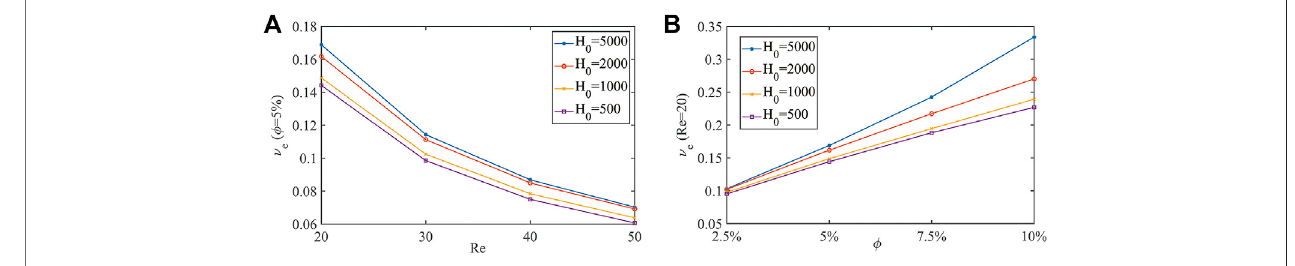
FIGURE 15 | Variation of effective kinematic viscosity ] e of suspension with Reynolds number in different magnetic fi eld strength H 0 when φ is 5% (A) . Variation of effective kinematic viscosity ] e of suspension with volume fraction in different magnetic fi eld strength H 0 when Re is 20 (B)